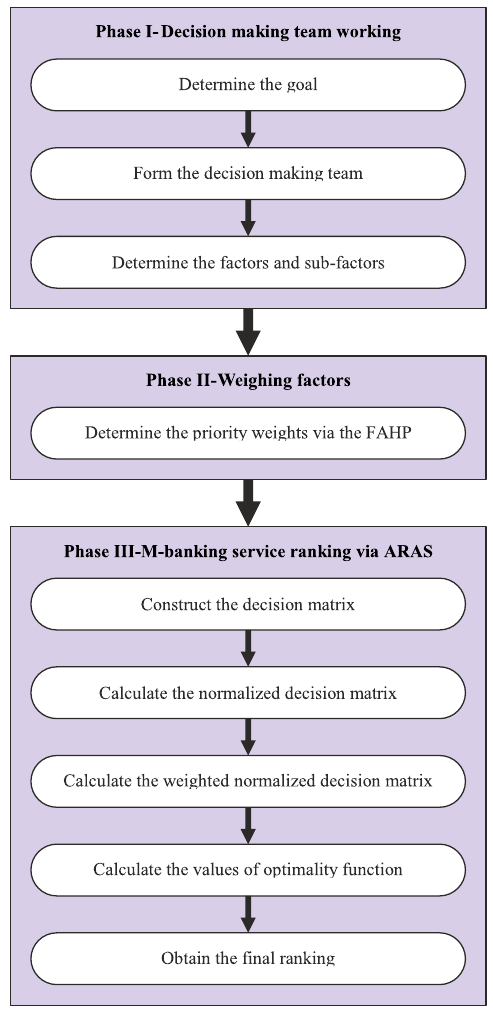
Fig. 2. The proposed integrated fuzzy